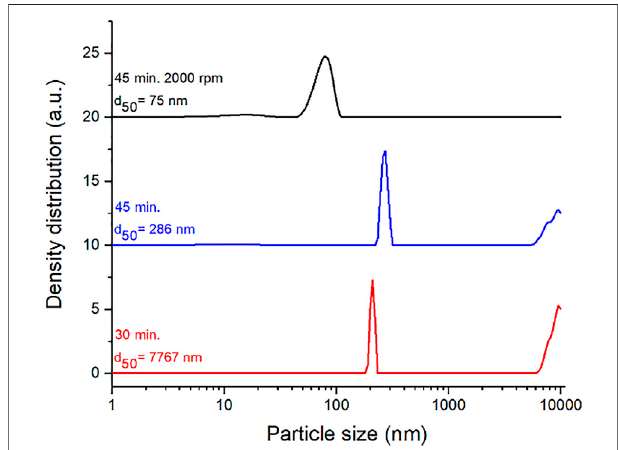
FIGURE4| Progressofparticlesizedistributionduringwetstirredmedia milling of CuS in BSA solution. Milling time, revolutions of centrifugation and average hydrodynamic diameter (d 50 ) are de fi ned in the fi gure.